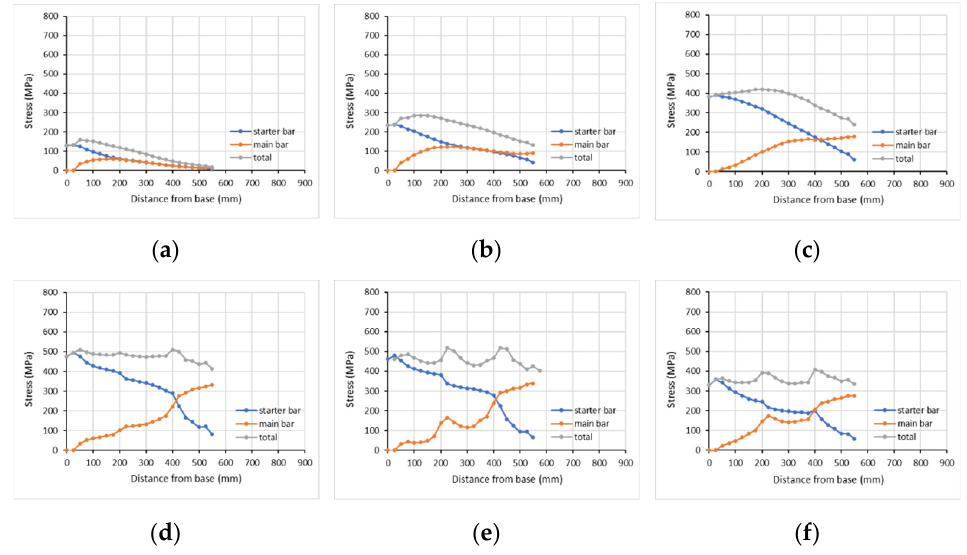
Figure 15. Developed stress along lap splice length at a displacement of ( a ) 2.07 mm, ( b ) 4.20 mm, ( c ) 6.58 mm ( δ py ), ( d ) 36.21 mm ( δ P € ), ( e ) 49.30 mm ( δ y ), and ( f ) 69.11 mm ( δ u ), for column